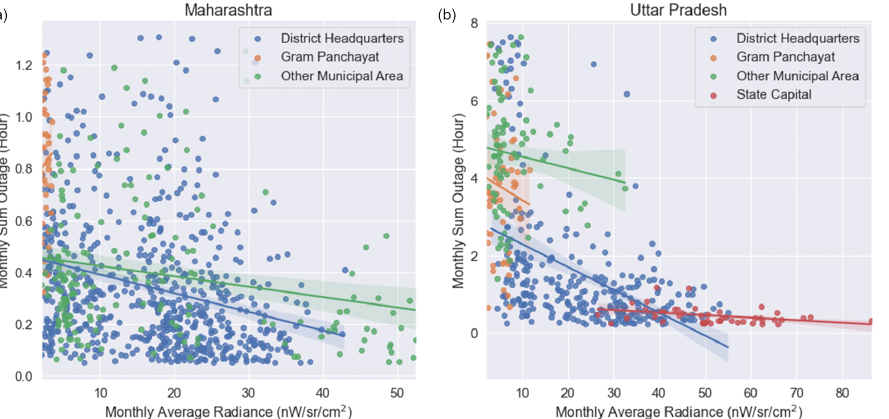
Figure 26. Scatter plot showing the relationship of power outage and radiance for ( a ) Maharashtra and ( b ) Uttar